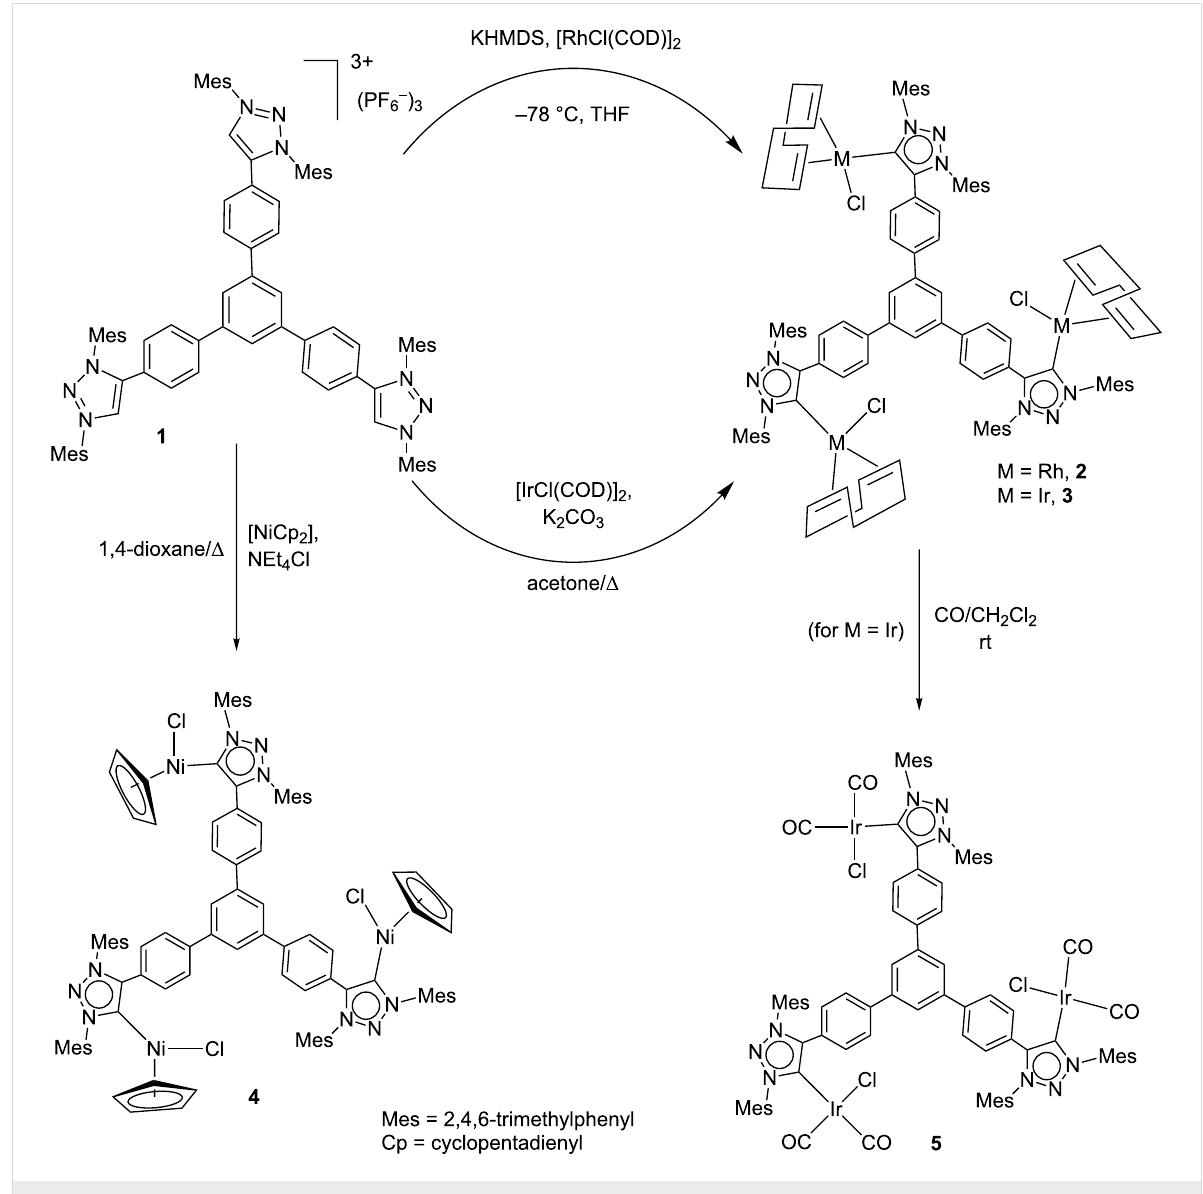
Scheme 2: Synthesis of rhodium(I), iridium(I), and nickel(II) complexes of ligand B .